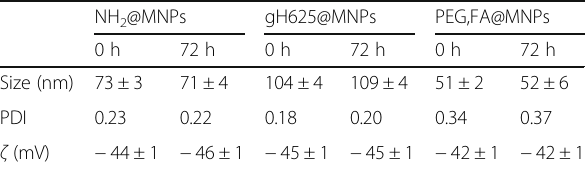
Table 1 Mean hydrodynamic diameter, polydispersity index (PDI), and zeta potential of functionalized MNPs determined by DLS in PBS as prepared and after 72 h of aging